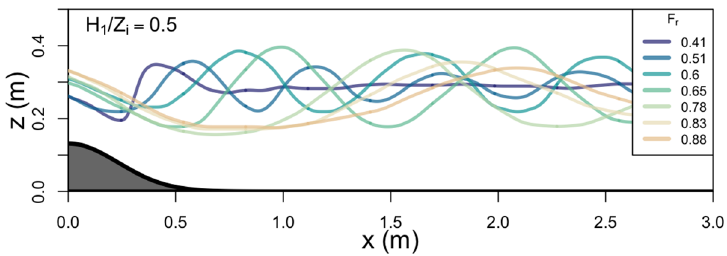
Figure 5. Interface displacement for a set of single obstacle runs with fixed H 1 /Z i = 0.5 and Fr ranging from 0.41 to 0.88, corresponding to flow regimes of hydraulic jump ( F r = 0.41), trapped lee waves ( F r = 0.51–0.78) and long waves ( F r = 0.83–0.88).